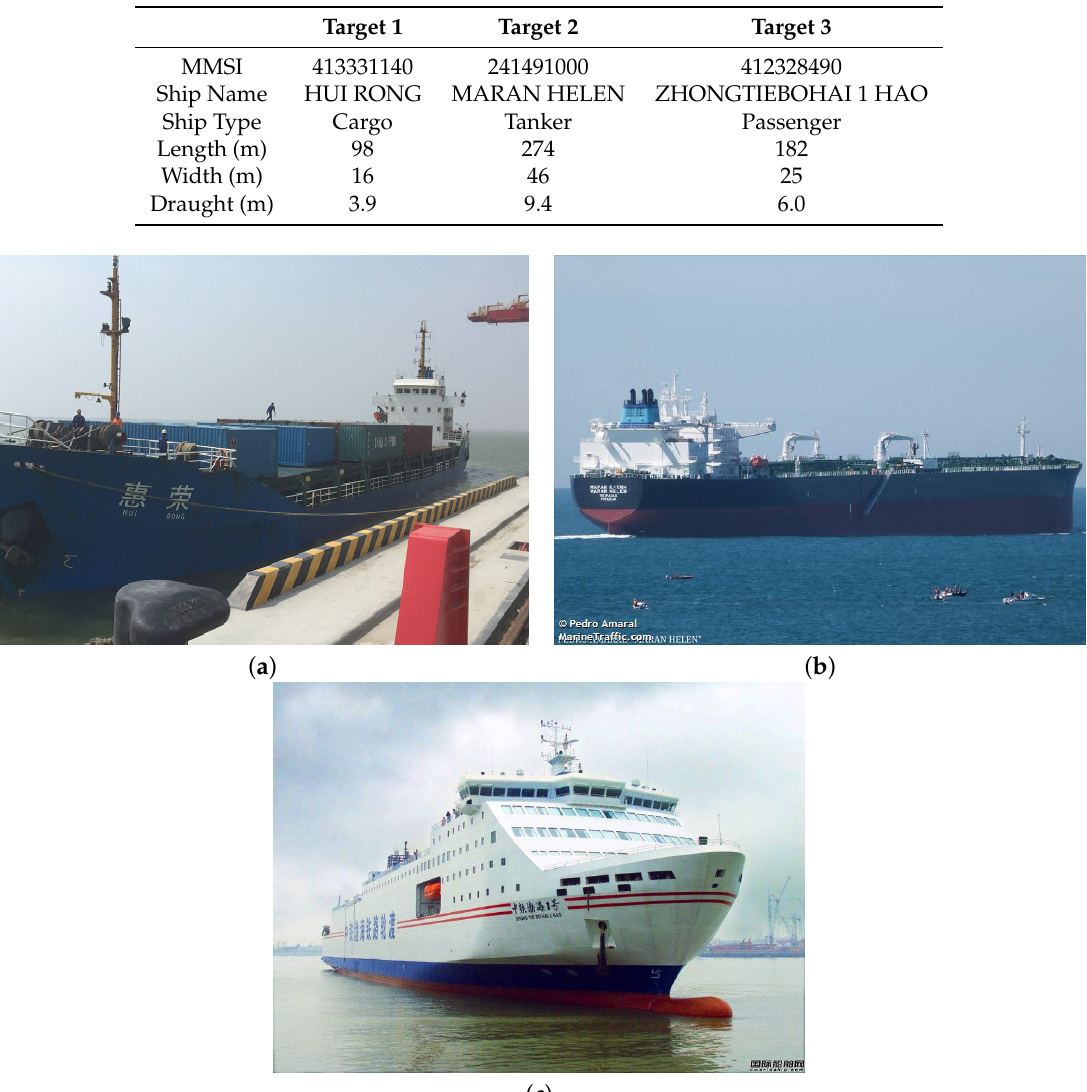
Table 1. General information for three targets.